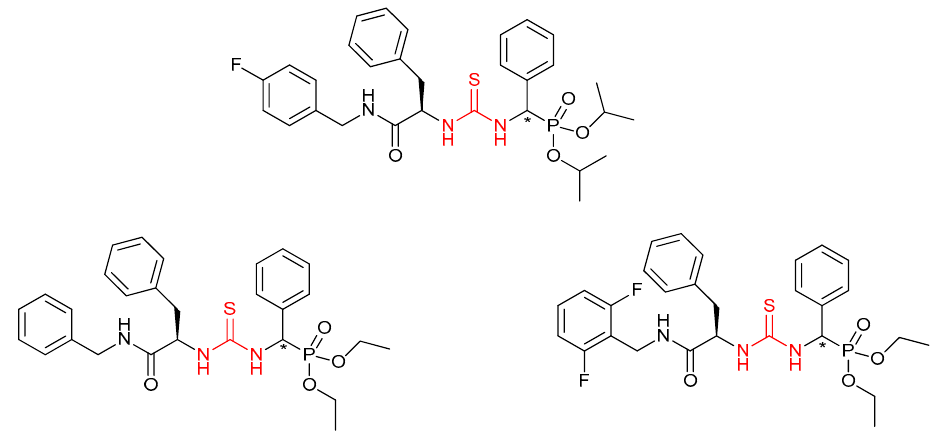
Figure 40. Potential lead compounds displaying antiproliferative activity in vitro [376–378].